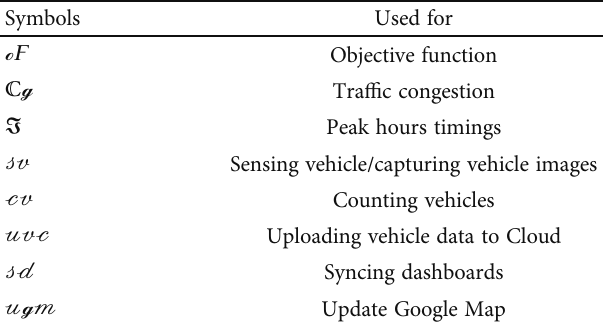
Table 1: Symbols used for mathematical modeling.